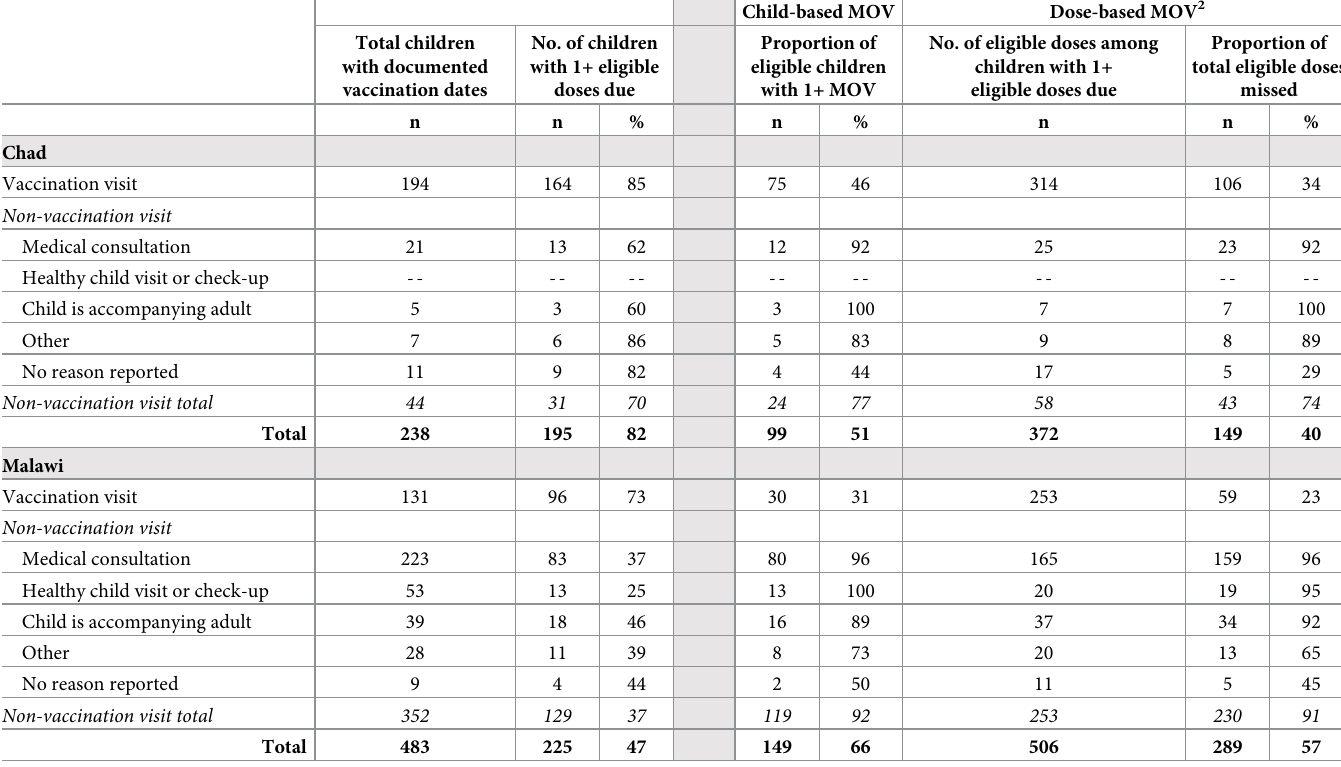
Table 3. Missed opportunities for vaccination (MOV) 1 by reason for visit, Chad and Malawi, 2015.